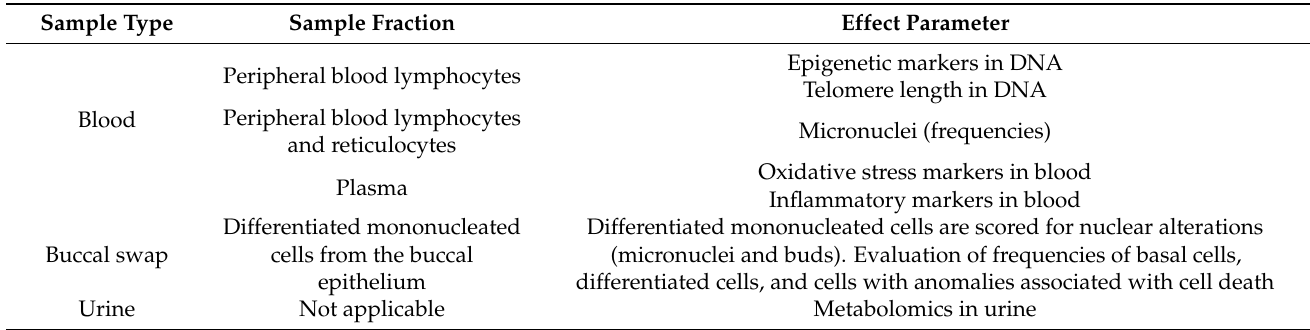
Table 3. Biological samples for determination of effect